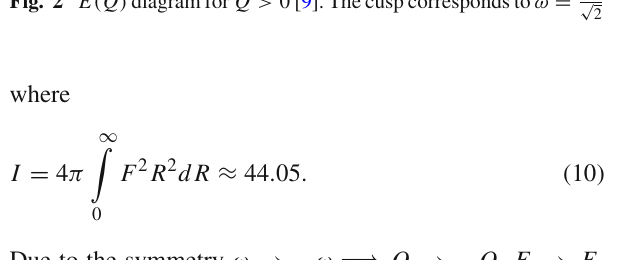
Fig. 2 E ( Q ) diagram for Q > 0 [9]. The cusp corresponds to ω = m √